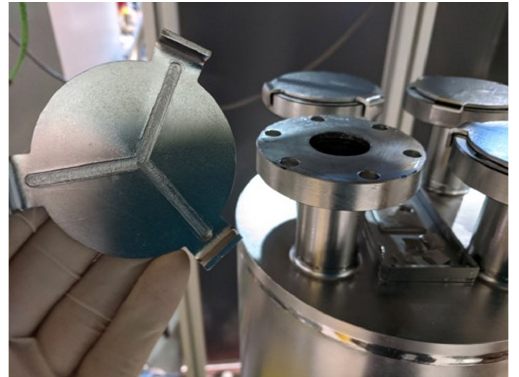
FIG. 5. Slotted Nb caps used to limit line of sight toward the rf surface while providing a defined and reproducible leak for gas flow from rf volume to the furnace volume.